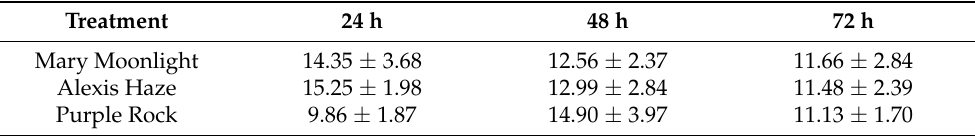
Figure 4. Dose–response curves of THC, CBD, and MIX THC CBD. HepG2 cells were grown for 24 h ( a ), 48 h ( b ), 72 h, and ( c ) in the presence of increasing concentrations of the two cannabinoids, THC and CBD, either as single agents or in dual combinations prepared at a 1:9 ratio. The cell viability was assessed with the MTT test and the concentration required to reduce the cell number by 50% (IC 50 ) for each condition in HepG2 cells was calculated using GraphPad Prism. Each data point represents the mean of at least three separate experiments and the vertical bars represent the standard deviation. Table 4. IC 50 of Mary Moonlight, Alexis Haze, and Purple Rock against HepG2 cells as determined Table 5. IC 50 of THC, CBD, and MIX THC CBD against HepG2 cells as determined by the MTT assay.